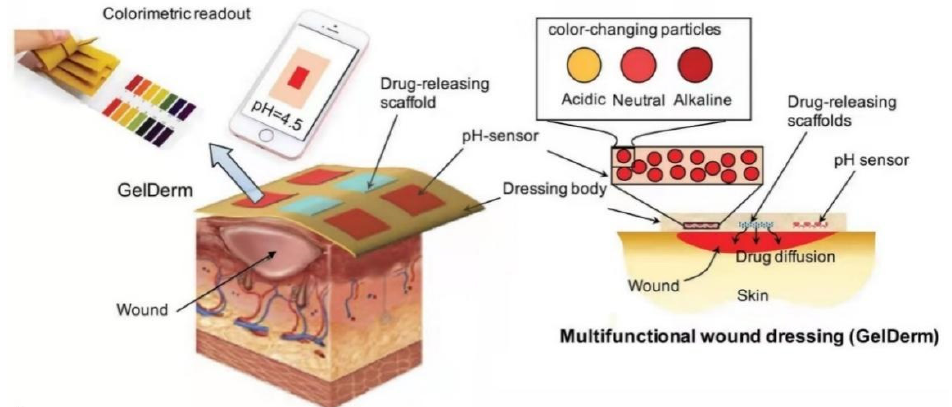
Figure 6. GelDerm is a multifunctional dressing for wound monitoring and management. When skin is damaged, the acidic environment can be disturbed. GelDerm is capable of colorimetric pH measurements, connects to an internal smartphone app (iDerm), records a digital image of the GelDerm, reports the pH, and releases antibiotics into the wound site. Reproduced with permission from Ref. [91]. Published by Wiley, 2017.